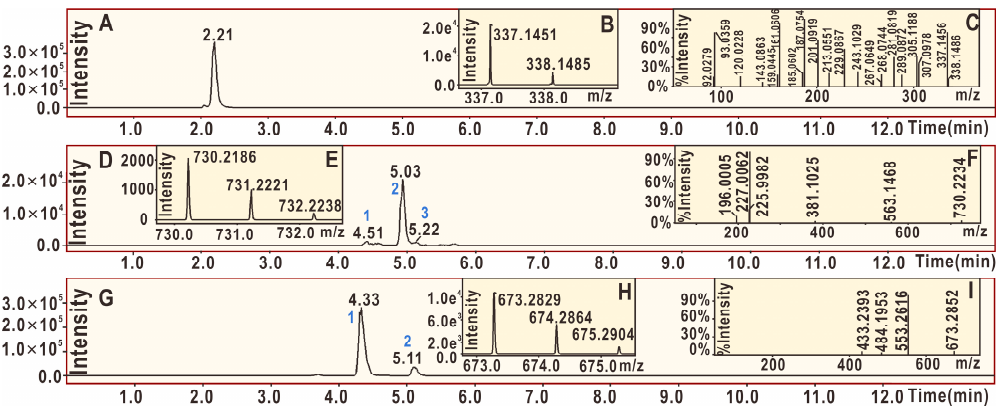
Figure 9. Main results of the UPLC-ESI-Q-TOF-MS/MS analysis of licochalcone A: ( A ) total ion chromatographic diagram of licochalcone A; ( B ) primary MS spectrum of licochalcone A; ( C ) MS/MS spectrum of licochalcone A; ( D ) total ion chromatographic diagram of the licochalcone A–DPPH adduct extracted by [C 39 H 33 N 5 O 10 -H] − ; ( E ) primary MS spectrum of the licochalcone A–DPPH adduct; ( F ) MS/MS spectrum of the licochalcone A–DPPH adduct from peak 2 in ( D ); ( G ) total ion chromatographic diagram of the possible dimeric products of licochalcone A extracted by [C 42 H 42 O 8 -H] − ; ( H ) primary MS spectrum of the licochalcone A–licochalcone A dimer; and ( I ) MS/MS spectrum of the licochalcone A–licochalcone A dimer from peak 1.